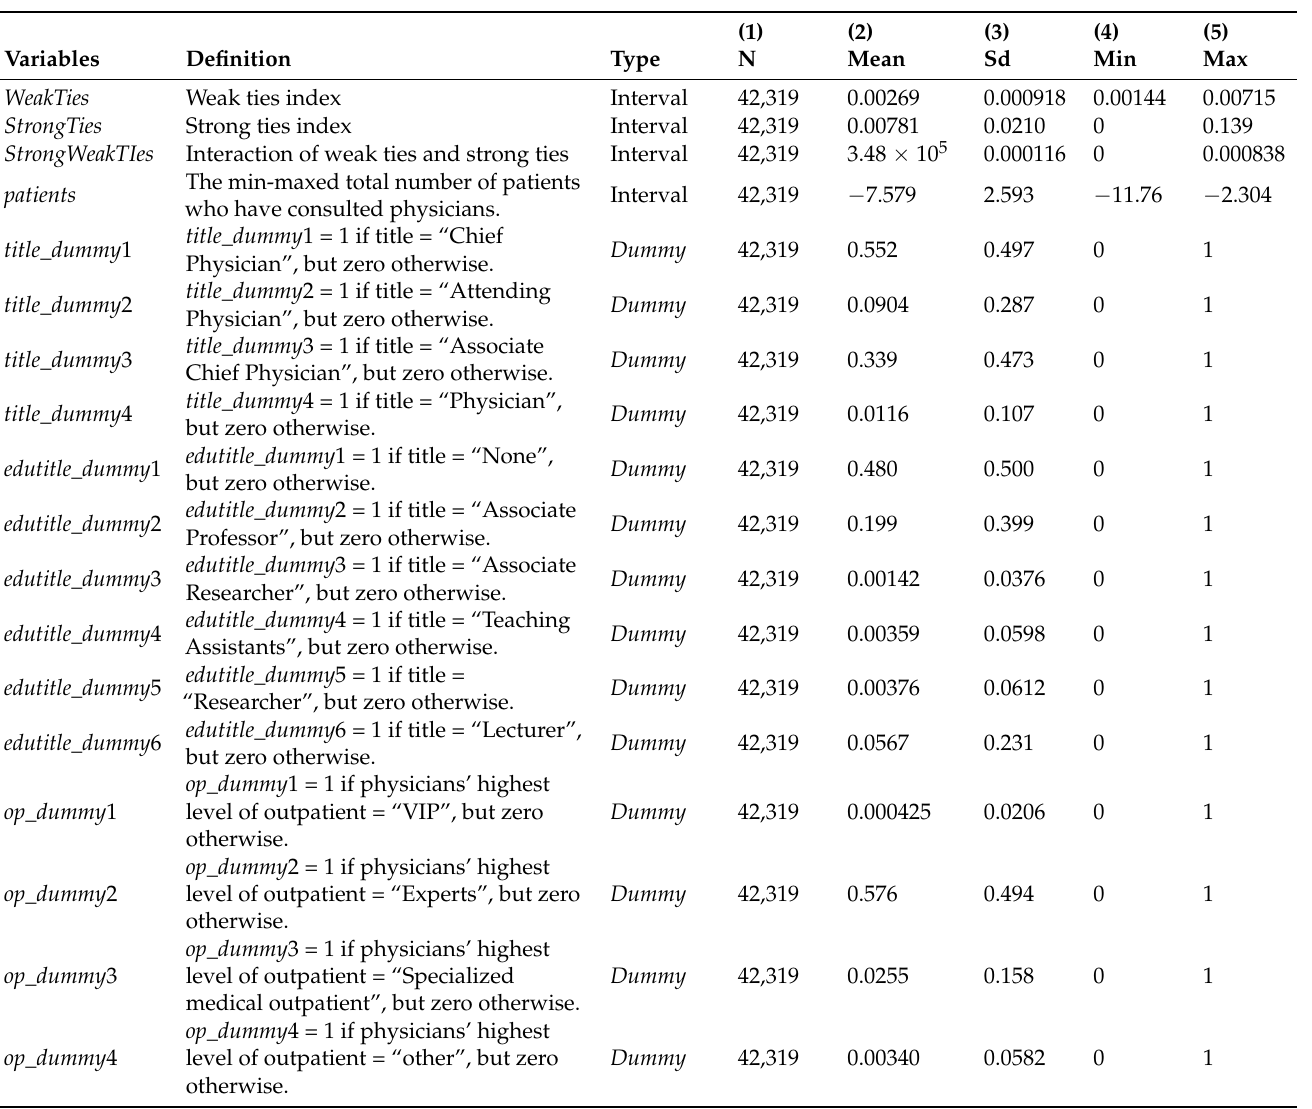
Table 2. Definitions of the Variables and summary